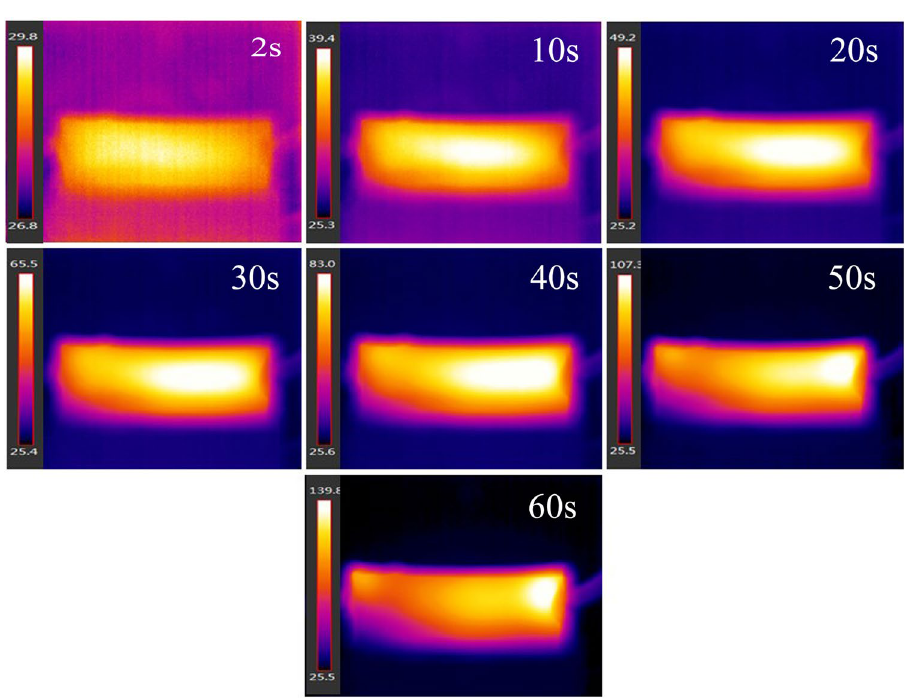
Figure 11. Surface temperature distribution of the PGSE with 10 wt% graphite sheets and 3 wt% AgNWs in the recovery